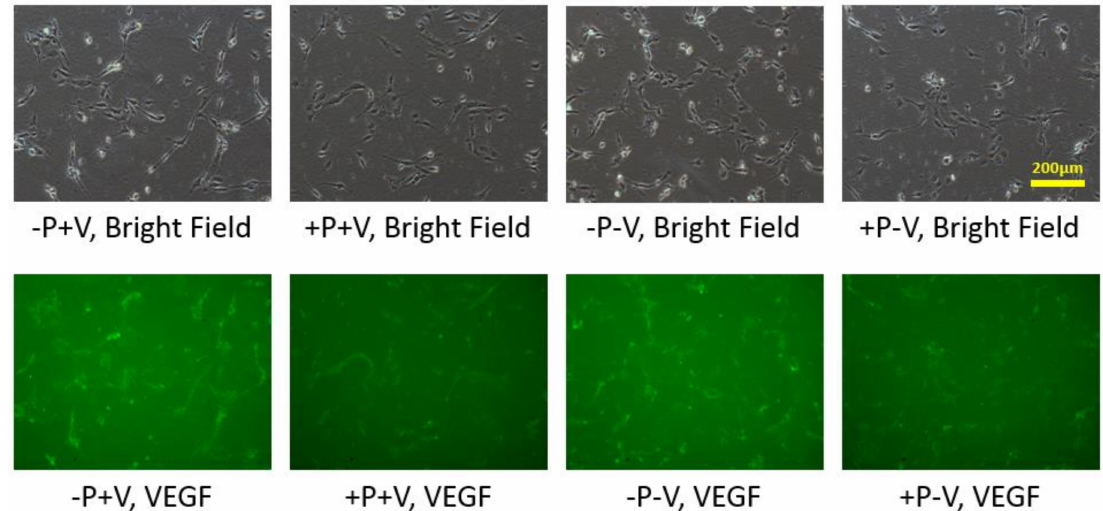
Figure 3. Bound VEGF location after 6 h of incubation in different cell culture conditions: without VBP ( − P), with VBP (+P), without VEGF ( − V), and with VEGF (+V). A fluorescent signal from the primary antibody against VEGF was detected on the cell membrane and biogel surface. The VBP shielding effect avoided VEGF from binding biogel resulting in the darker VEGF field in both the +P − V and +P+V